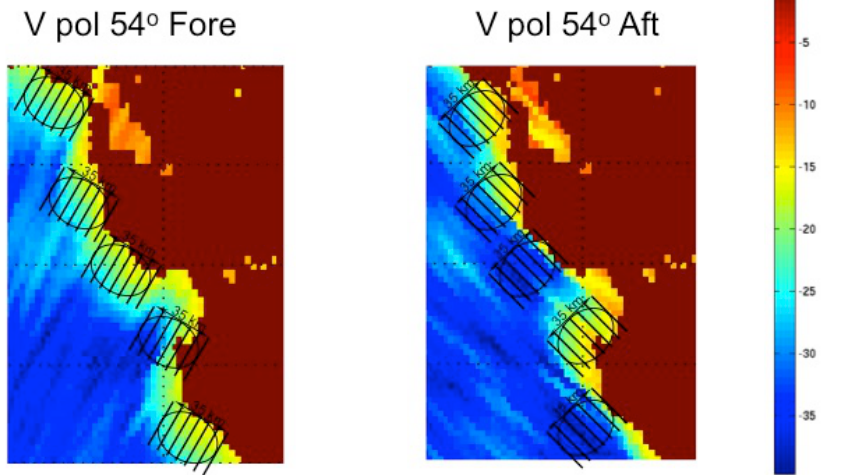
Figure 3: As in Figure 2 with the region near Monterrey Bay expanded and the orientation of the range slices illustrated.